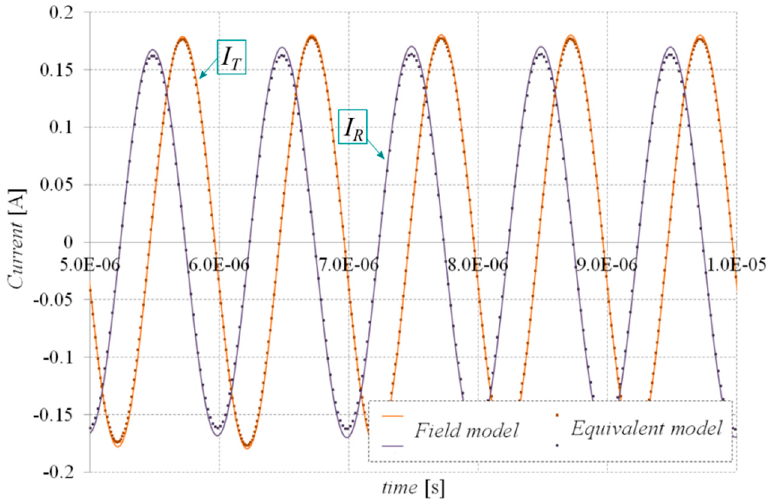
Figure 8. Comparison of receiver and transmitter currents of the WPTS determined by 3D FEA and the proposed equivalent model for the frequency of a supply source equal to 1 MHz.